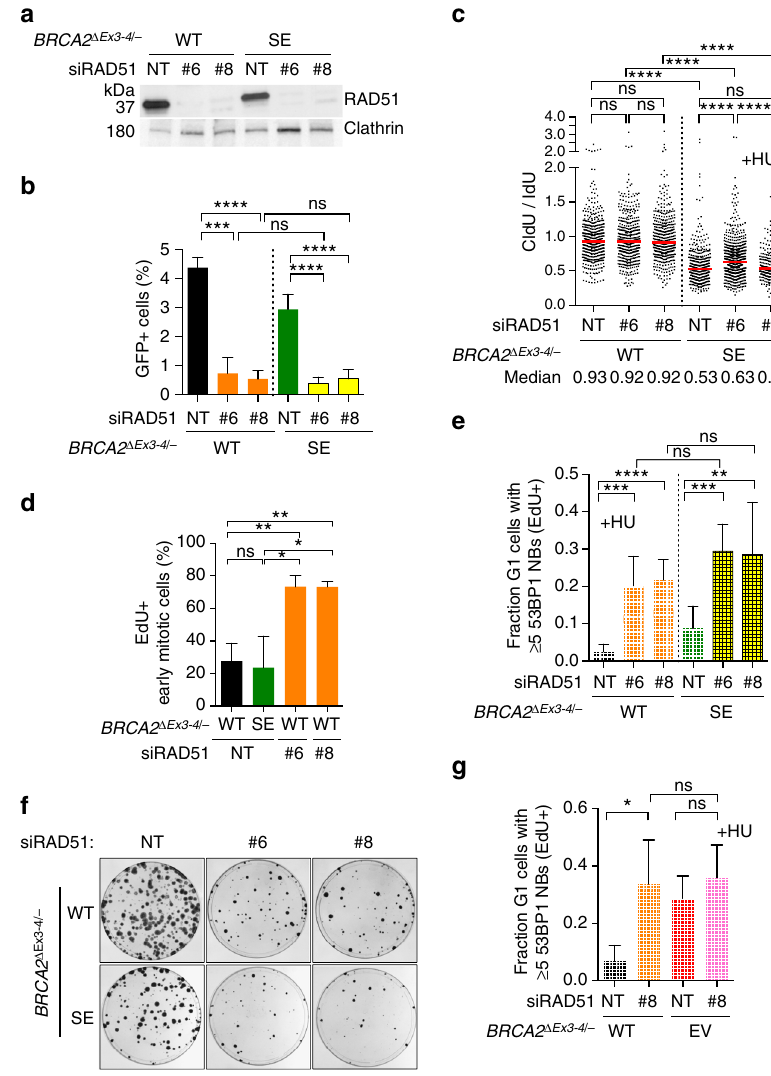
Fig. 7 HR pro fi ciency is associated with replication stress suppression and cell viability. a Western blot showing RAD51 knockdown in BRCA2 Δ Ex3-4/ – cells stably expressing BRCA2 WT or BRCA2 SE. NT, non targeting siRNA. b HR analysis. Cells expressing RAD51 siRNAs were infected with I-SceI-expressing lentivirus and the percent GFP+ cells was analyzed by an unpaired two-tailed t -test. n ≥ 3. c Cells expressing RAD51 siRNAs were analyzed for fork protection in the presence of HU. Median CldU/IdU tract length ratios are indicated in the graph ( red bars ). Graphs represent the pooled results of > 300 fi bers per genotype from at least three independent experiments, analyzed by a two-tailed Mann – Whitney test. d Cells expressing RAD51 siRNAs were released for 22 h from serum starvation to increase mitotic cells, incubated with EdU 1 h, and then analyzed for mitotic DNA synthesis. Early mitotic cells, de fi ned as being in prophase, prometaphase, or metaphase, were analyzed for EdU foci that co-localize with FANCD2 foci pairs. The percent early mitotic cells containing EdU foci were analyzed by an unpaired two-tailed t -test. n = 3. e HU-induced 53BP1 nuclear body formation analysis, as in Fig. 4d, using cells expressing RAD51 siRNAs. Statistical analysis was by an unpaired two-tailed t -test. n ≥ 4. f RAD51 depletion in BRCA2 Δ Ex3-4/ – cells stably expressing BRCA2 WT or BRCA2 SE leads to a reduction in clonogenic survival. g HU-induced 53BP1 nuclear body formation analysis, as in Fig. 4d, using cells transfected with RAD51 siRNAs. Statistical analysis was by an unpaired two-tailed t -test. n = 4. Error bars s.d. ns, not signi fi cant; * p < 0.05; ** p <